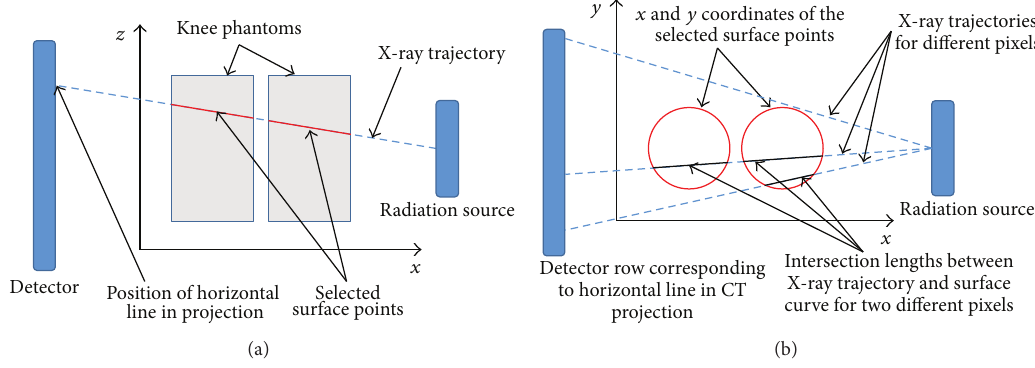
Figure 7: (a) The necessary surface points for the correction are selected by first disregarding the 𝑦 -component of the points and the intersecting X-ray. Only surface points that have the same 𝑧 coordinate as the trajectory line at their 𝑥 coordinate are selected. (b) The calculation of the curve-line intersections is performed in 2D by only regarding the 𝑥 - and 𝑦